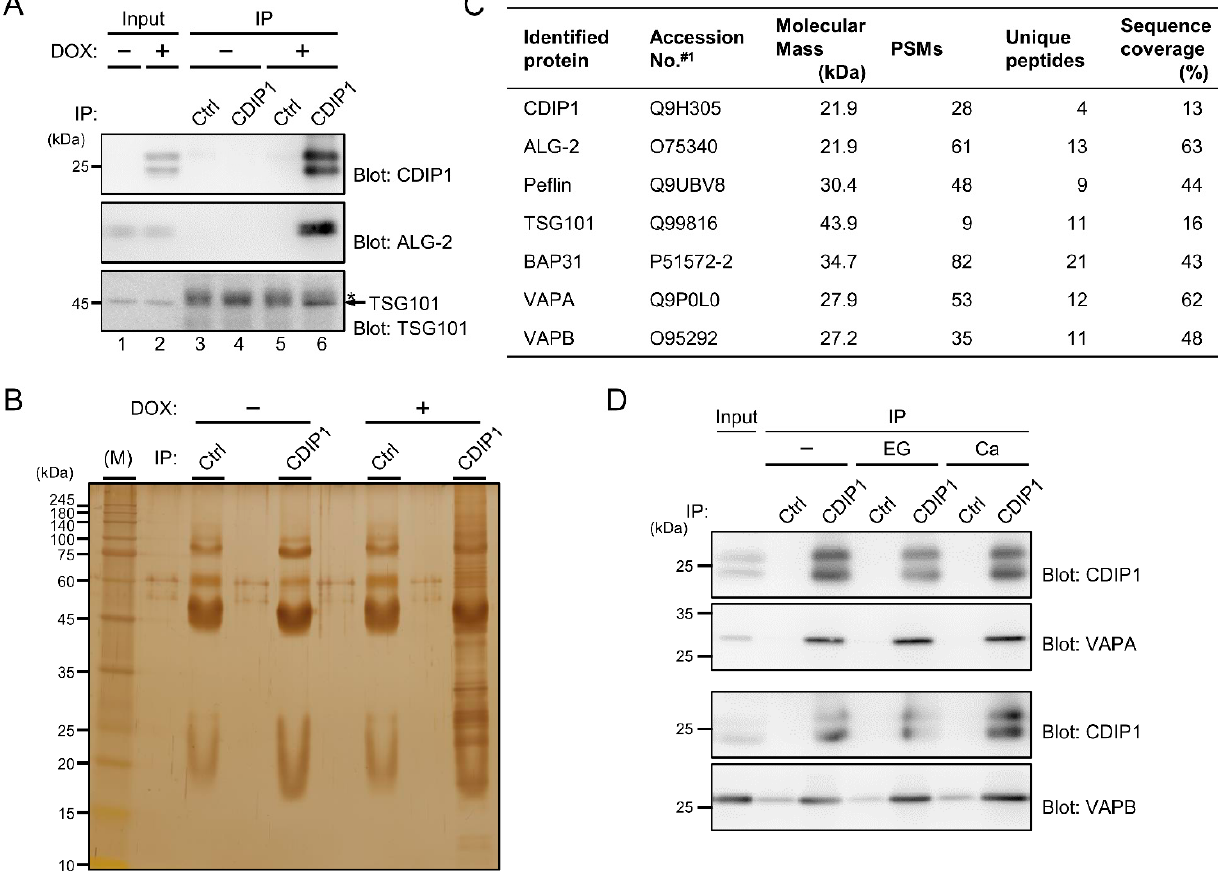
Figure 7. Interaction of CDIP1 with VAPA and VAPB. ( A , B ) Co-IP analysis of MCF-7 Tet-On CDIP1 cells cultured in the absence ( − ) or presence (+) of the tetracycline analogue doxycycline (DOX). Cleared cell lysates (Input) and IP products (IP) obtained with an antibody against CDIP1 (CDIP1) or control IgG (Ctrl) were subjected to SDS-PAGE followed by immunoblotting with antibodies against CDIP1, ALG-2 and TSG101 ( A ). The relative amounts of cleared cell lysate proteins (Input) used for analysis of IP products (IP) were 20% (upper panel) and 1% (middle and lower panels). An asterisk indicates the migration position of IgG heavy chain proteins. IP products obtained with the antibody against CDIP1 (CDIP1) or control IgG (Ctrl) were subjected to SDS-PAGE followed by silver staining ( B ). ( C ) List of identified proteins in the IP product of the antibody against CDIP1 from cells cultured in the presence of DOX. #1, accession numbers in the UniProt database. ( D ) MCF-7 Tet-On CDIP1 cells were cultured in the presence of DOX. Cleared cell lysates (Input) and IP products (IP) obtained with the antibody against CDIP1 (CDIP1) or control IgG (Ctrl) in the absence ( − ) or presence of 5 mM EGTA (EG) or 10 μ M CaCl 2 (Ca) were subjected to SDS-PAGE followed by immunoblotting with antibodies against CDIP1, VAPA and VAPB. The relative amounts of cleared cell lysate proteins (Input) used for analysis of IP products (IP) were 20% (blot for CDIP1) and 1% (blot for VAPA and VAPB).